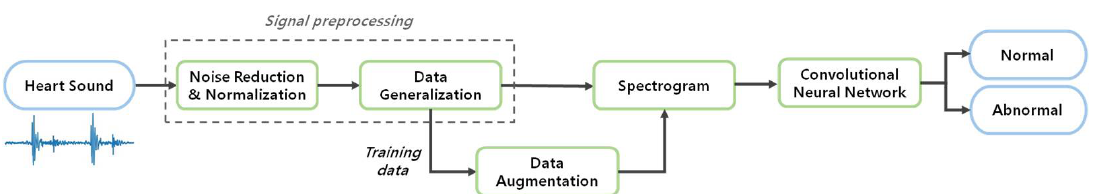
Figure 2. Block diagram of heart sounds identification system.